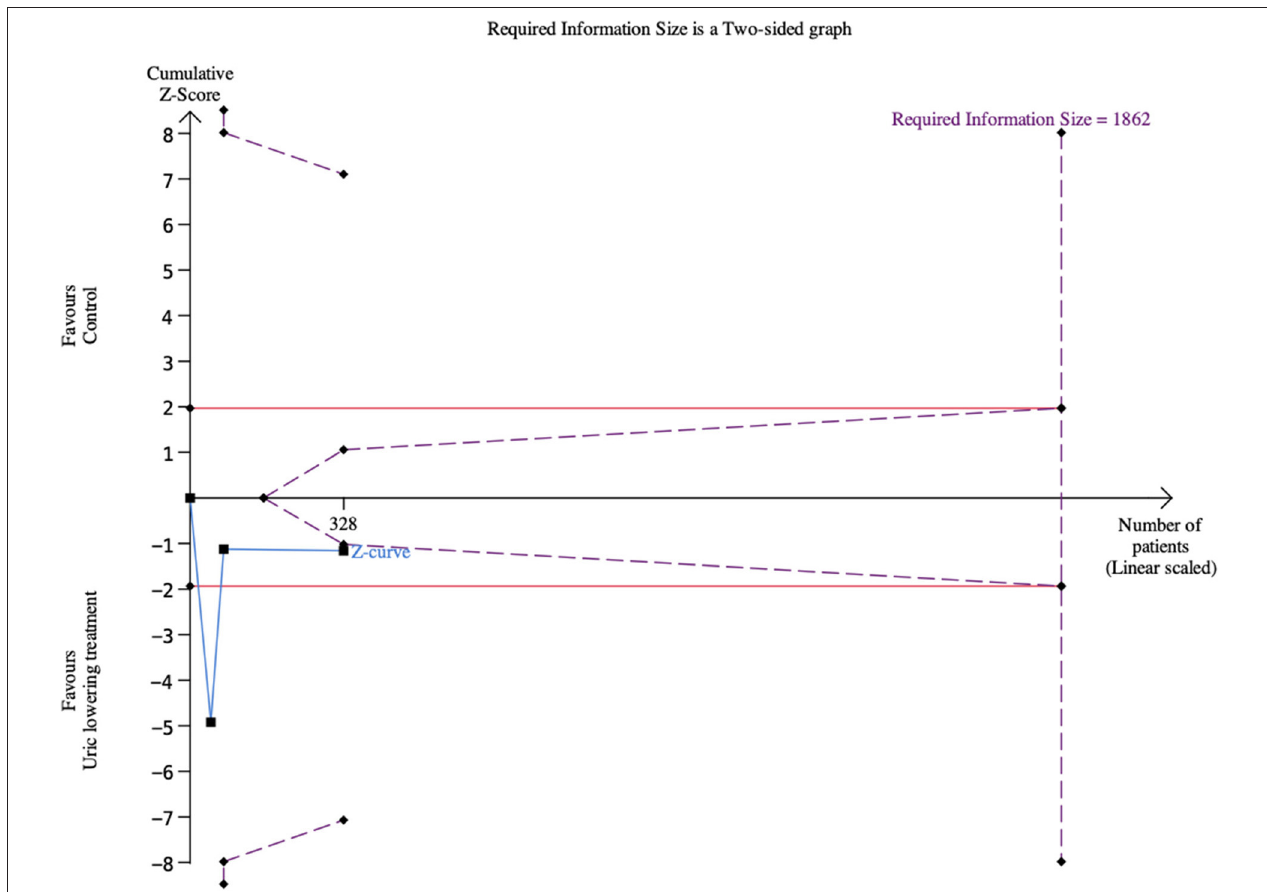
FIGURE 5 | Trial sequential analysis of left ventricular ejection fraction.